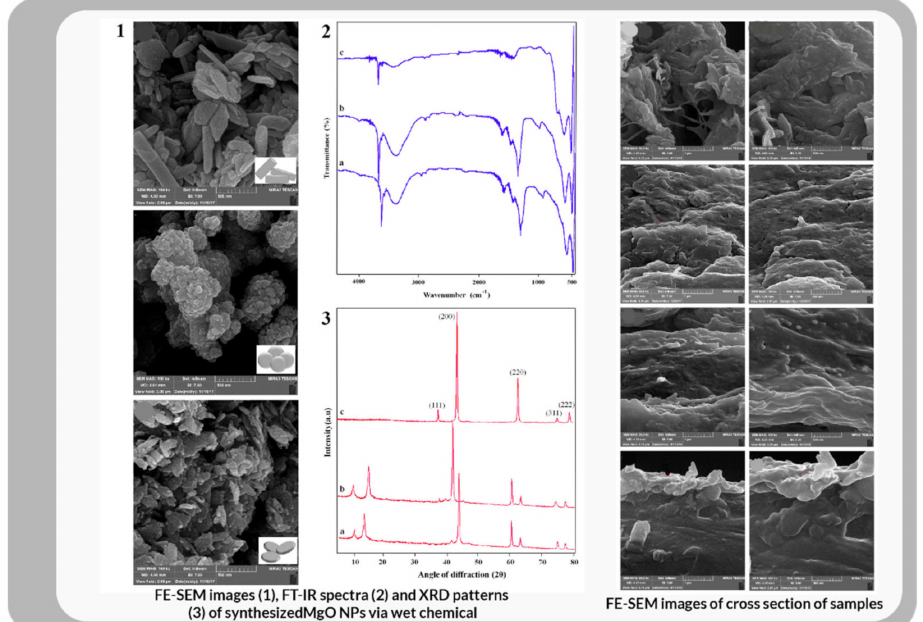
Figure 13. Image of novel MgO-BC nanohybrids prepared by in-situ and ex-situ methods using the hybrid modification method; Adapted with permission from